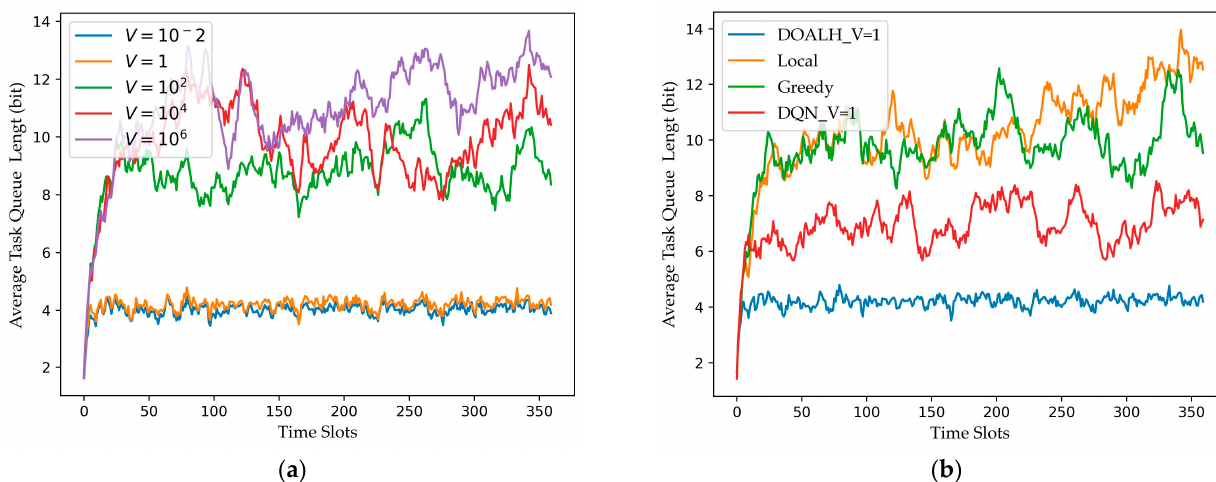
Figure 3. 𝑀 = 50, 𝛽 = 0.1,𝐵 = 500 (Mb/s) ( a ) Average task queue length per satellite vs. 𝑉 of DOALH algorithm; ( b ) Average task queue length per satellite vs. di ff erent algorithms. DOALH algorithm; ( b ) Average task queue length per satellite vs. different